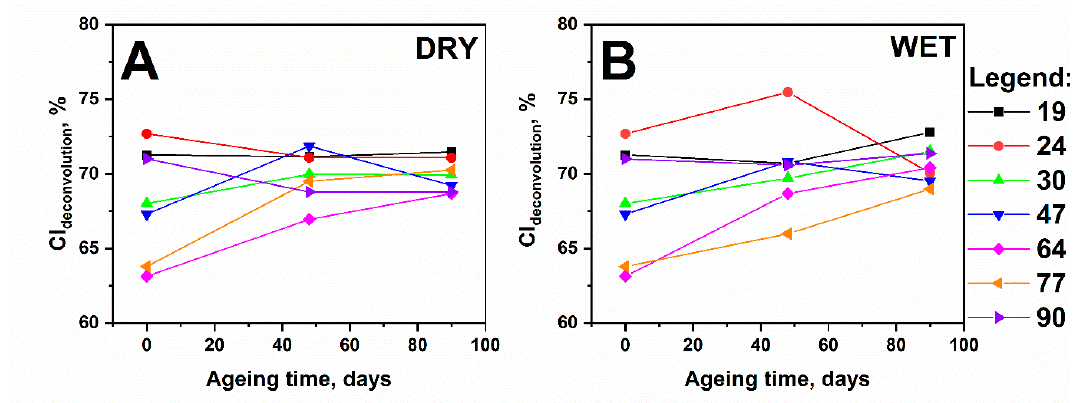
Figure 6. Values of crystallinity indexes and their changes in time under different ageing conditions: ( A ) dry atmosphere and ( B ) humid atmosphere.